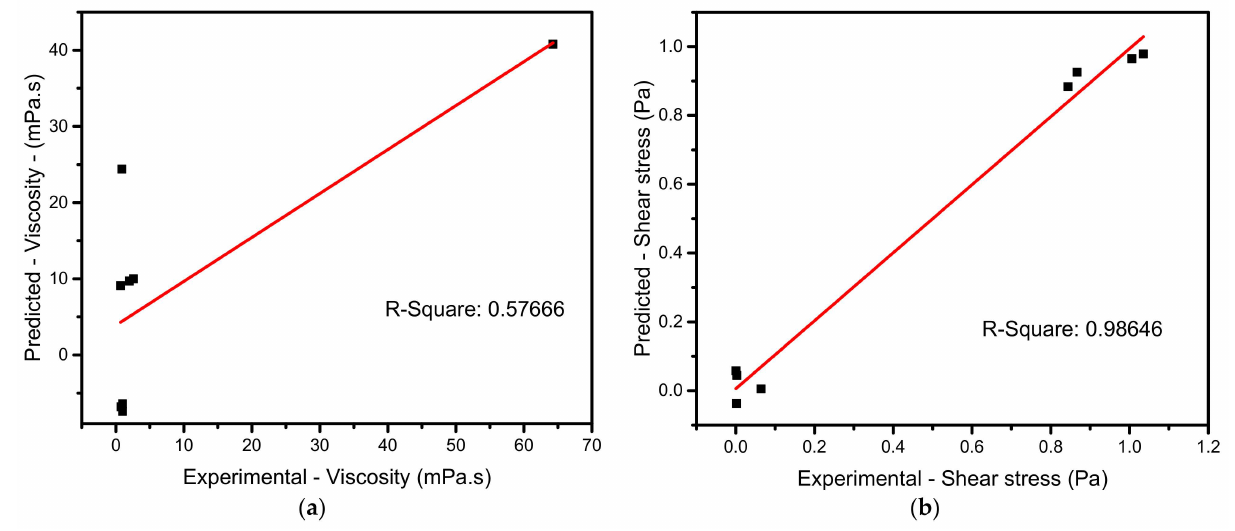
Figure 10. Regression prediction plots. ( a ) Viscosity; ( b ) Shear